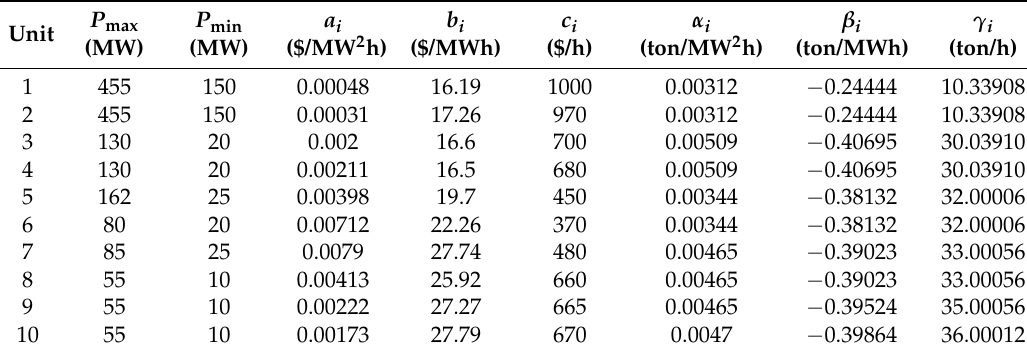
Table 1. Relevant Parameters of 10-unit Test System.